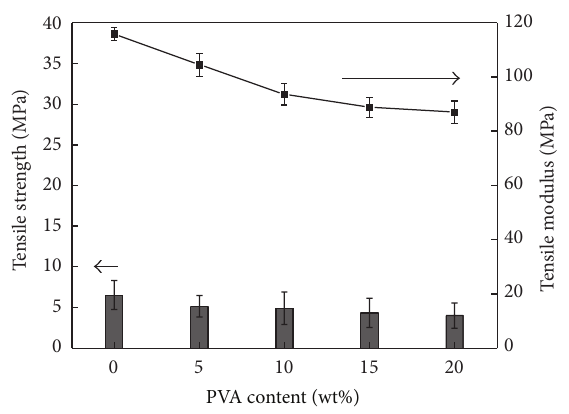
Figure 6: Tensile properties of the SPI film without PVA content.